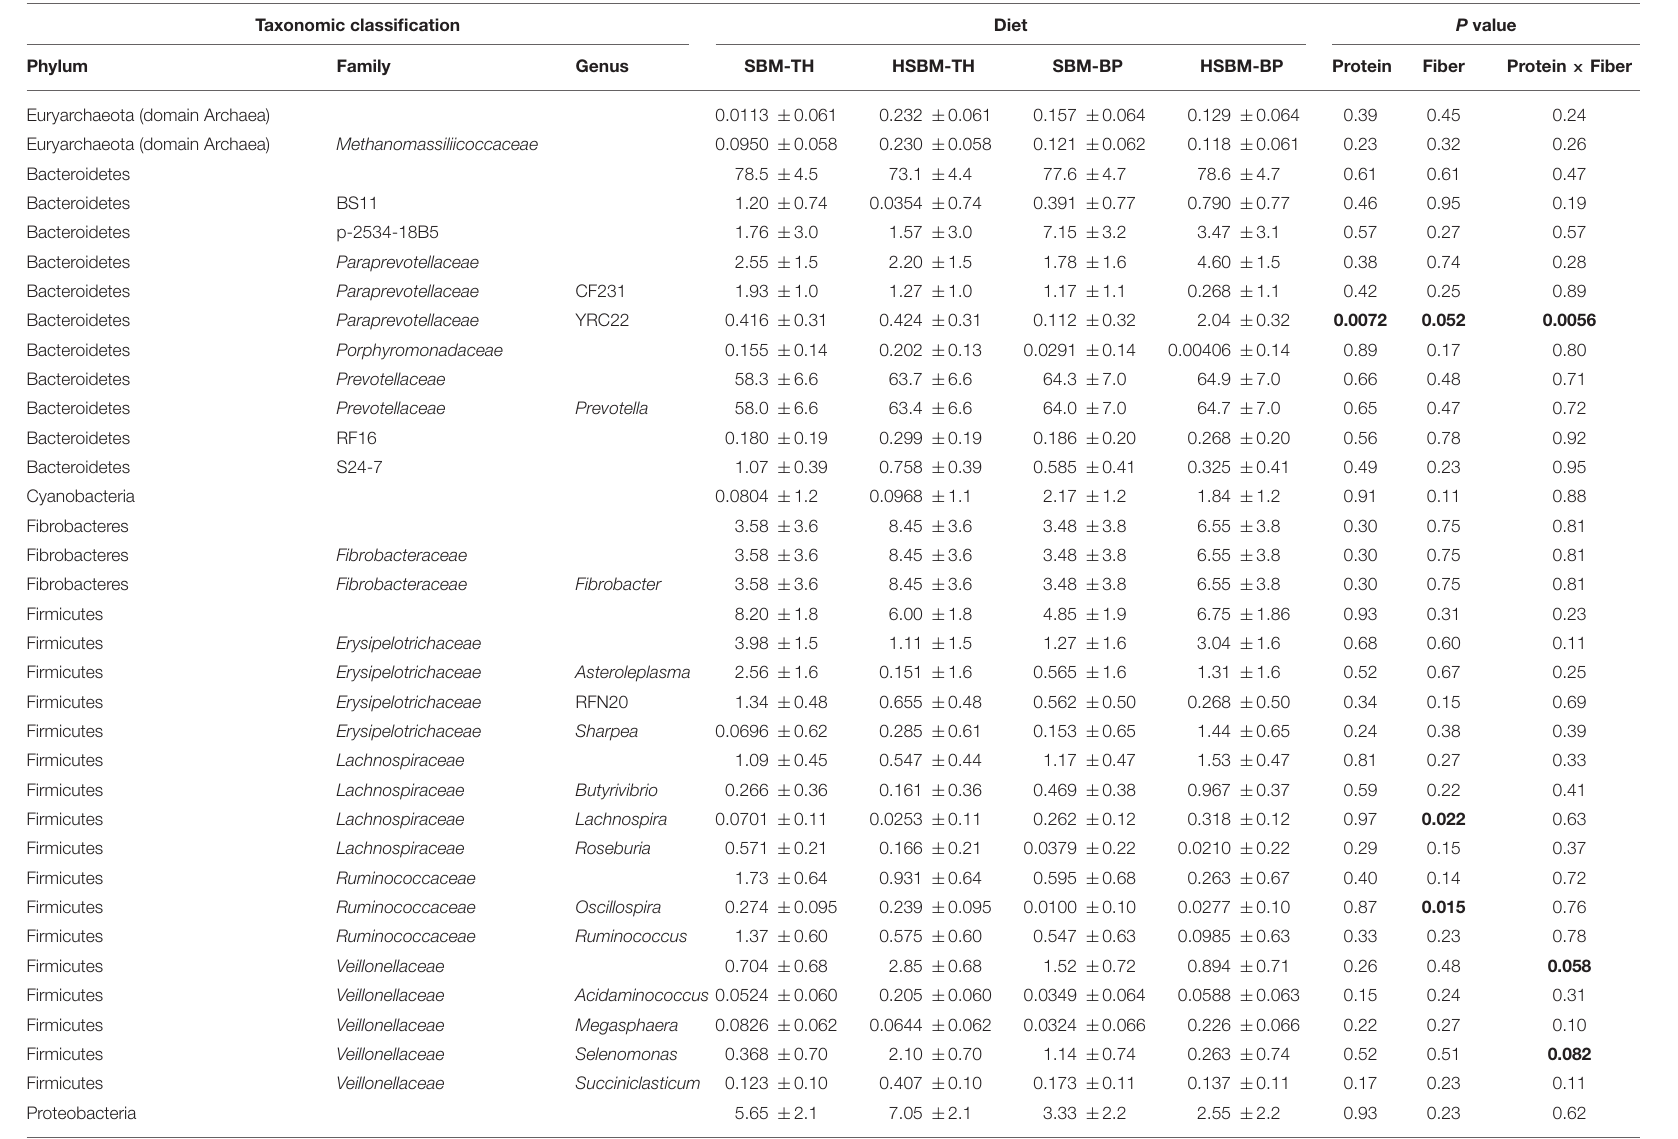
TABLE 2 | LS means ± SE for percent relative abundances of bacterial taxa identified in the rumen fluid fraction as differentiated by diet along with P values for the effects of protein source, fiber source, and the interaction of protein and fiber source a,b